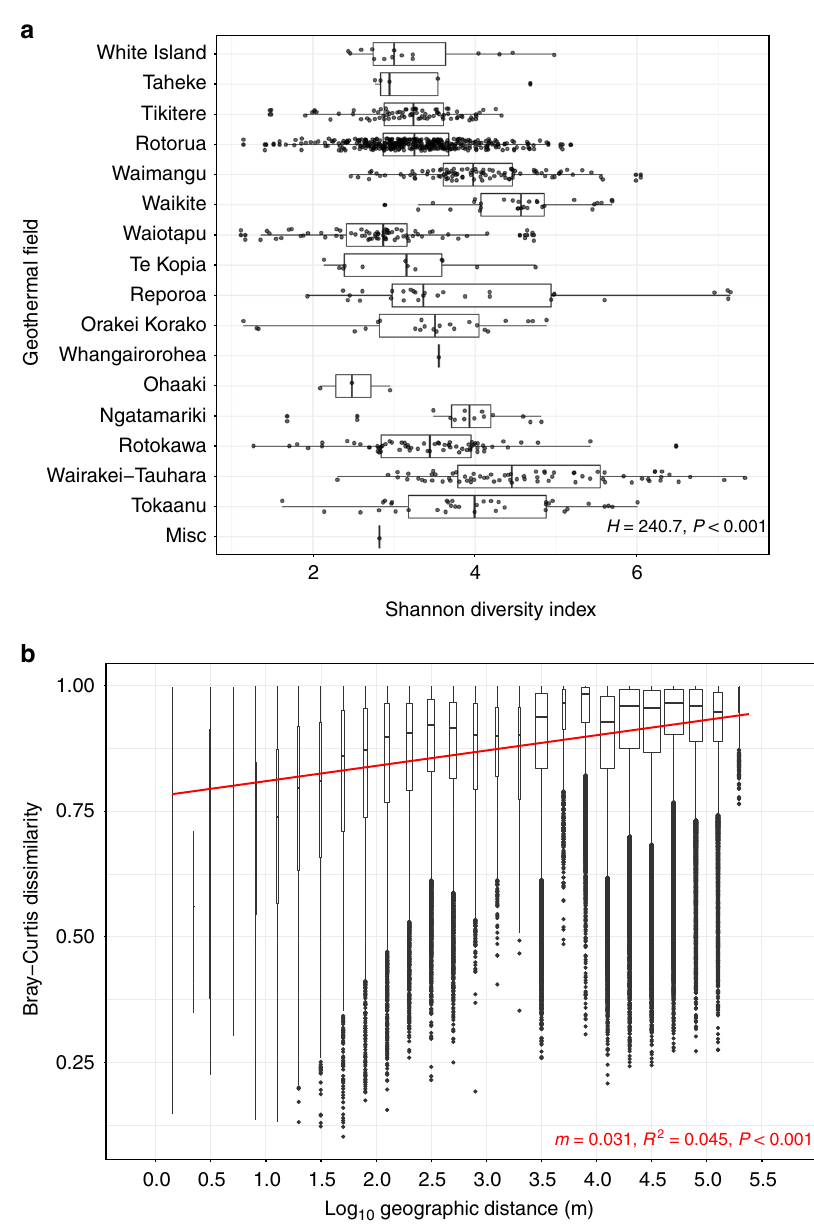
Fig. 4 Alpha and beta diversity as a function of geographic distance. a Alpha diversity scales (via Shannon index) across individual springs ( n = 925), split by geothermal fi elds. Fields are ordered from north to south ( H : Kruskal – Wallis test). b A distance-decay pattern of beta diversity (via Bray – Curtis dissimilarities of 925 springs) against pairwise geographic distance in metres, with linear regression applied ( m = slope). Geographic distance is split into bins to aid visualisation of the